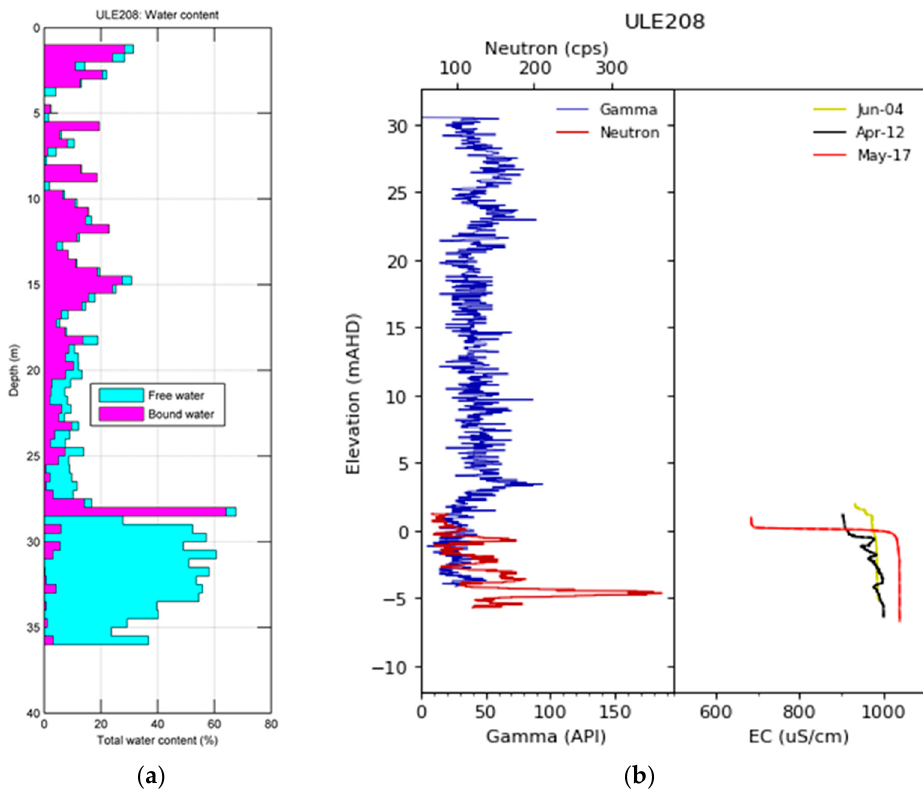
Figure 15. ( a ) sNMR total water content and conductivity profile at ULE208 [20]; ( b ) Gamma, neutron, and EC profiles for ULE 208 (surveyed ground elevation 30.5 m AHD).